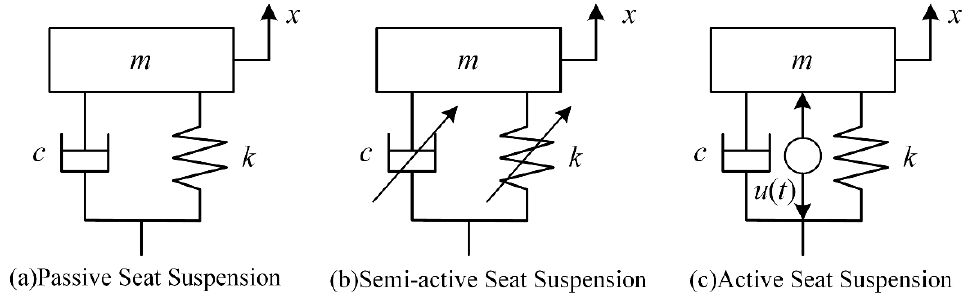
Figure 1. Schematic diagram of types of seat suspension.